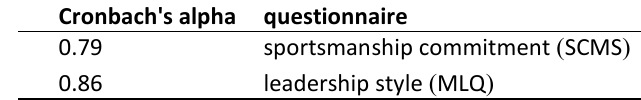
Table 1. Reliability of questionnaires